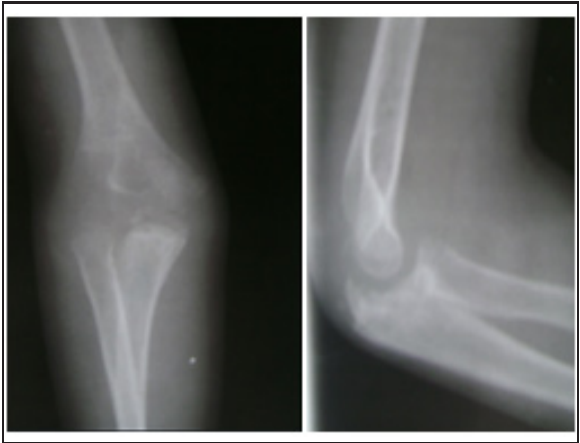
Figure 3. Radiographs, ten months after open reduc- tion, show normal articulation of the elbow